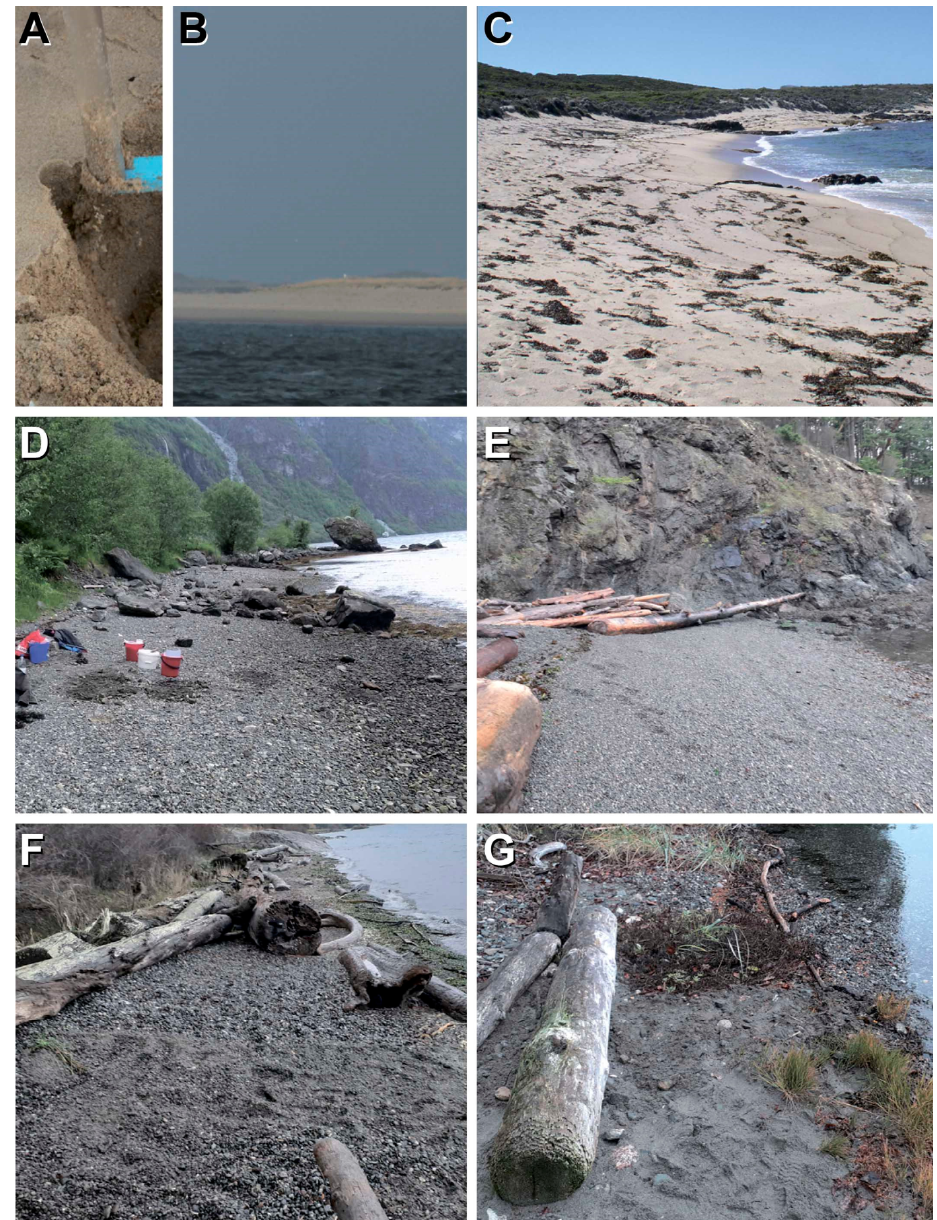
Figure 3. Pictures of the different beaches with known records of Stygocapitella . ( A ) Medium coarse sediment from Hausstrand, North Sea island Sylt; ( B ) Ellenbogen, North Sea island Sylt; ( C ) Sarge Bay, Australia; ( D ) Bakka, Norway; ( E ) Reid State Park, San Juan Island; ( F ) 4th of July beach, San Juan Island; ( G ) Roche Harbor, San Juan